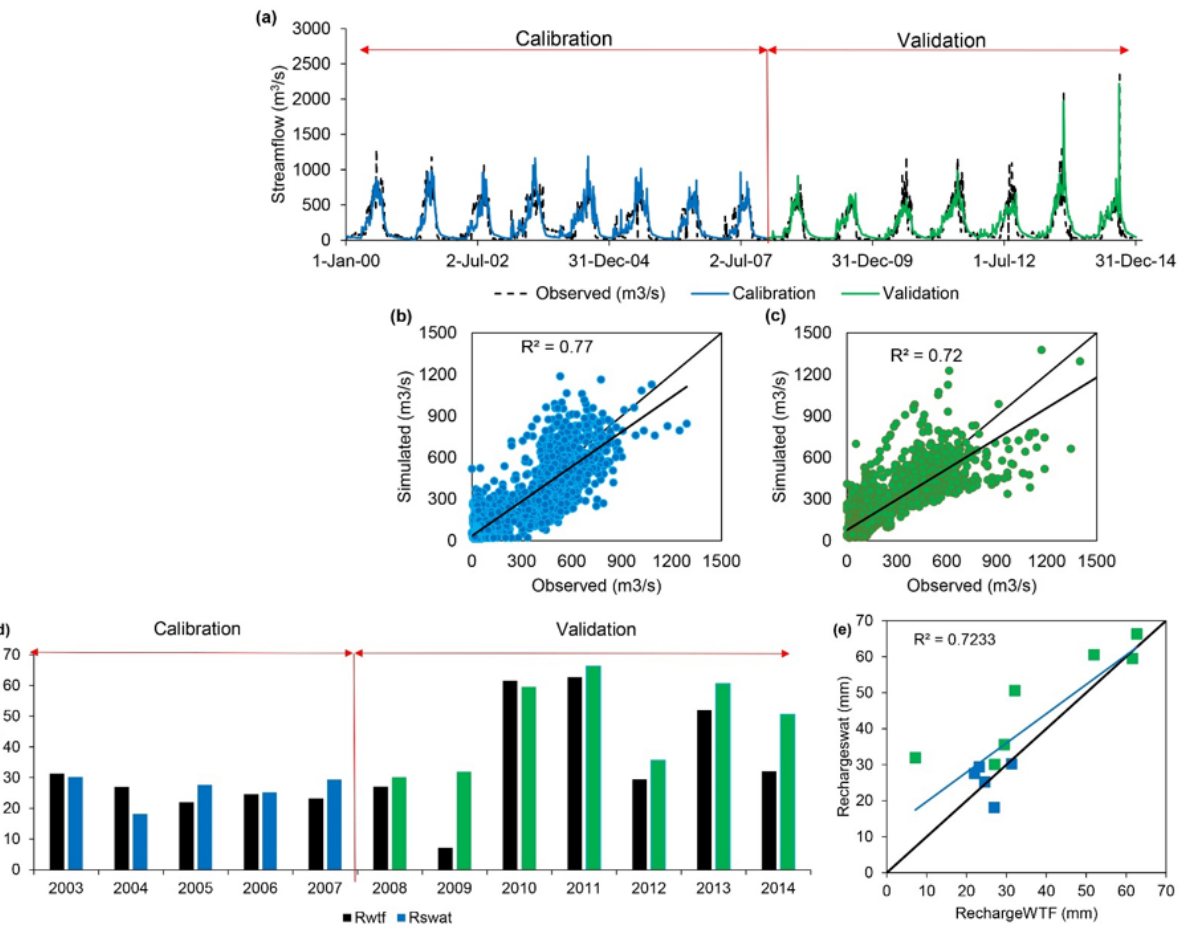
Figure 4. ( a – c ) Comparison between simulated and observed discharge for calibration and validation periods at Ravi siphon gauge based on daily time series and scatter plots; and ( d , e ) comparison between annual simulated and reference groundwater recharge for calibration and validation periods. Table 4. SWAT model performance for calibration and validation at Ravi syphon and Shahdara gauges.